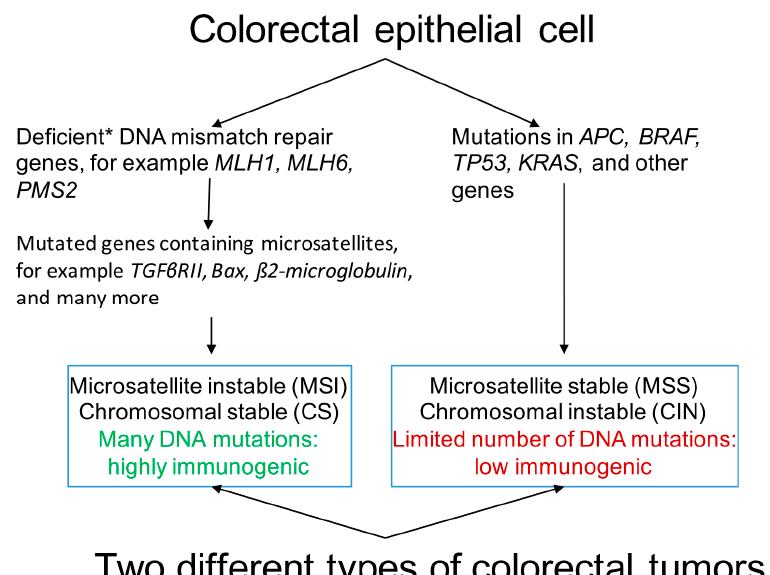
Figure 1. Colorectal cancer: two different types of tumors. Characteristics of the two main phenotypes of colorectal cancer are shown. * Deficiencies in DNA mismatch repair genes are due to genetic (DNA mutations) or epigenetic (methylation) aberrations in the genes coding for the responsible enzymes. The phenotype showing aberrant methylation is often indicated as the CpG island methylator phenotype (CIMP).